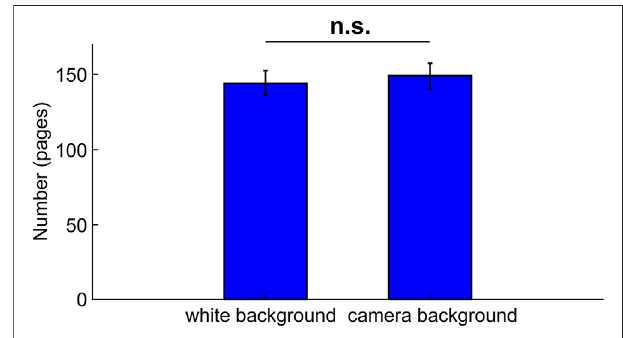
FIGURE 8 | Average REQ. The median REQ was signi fi cantly greater than zero.Errorbars indicatethestandarderror.Asteriskindicates statistically signi fi cant difference (* p < 0.01).